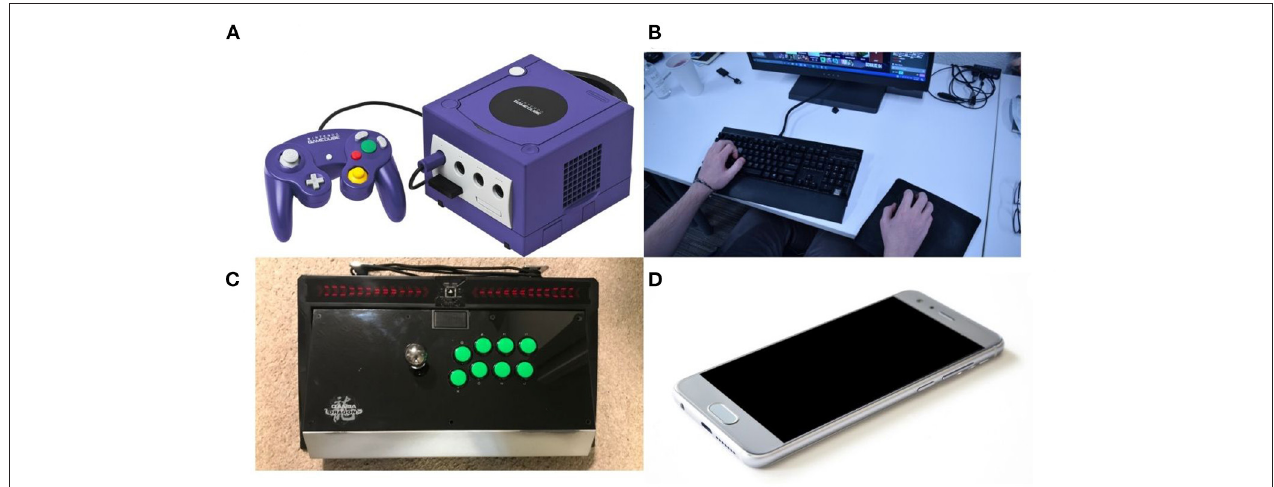
FIGURE 1 | Examples of controllers used in esports. (A) Gamecube controller, a typical example of a console controller. (B) Mouse and keyboard, used for personal computer (PC) gaming. (C) Arcade-style stick, most often used for console gaming. (D) Smartphone, used for mobile